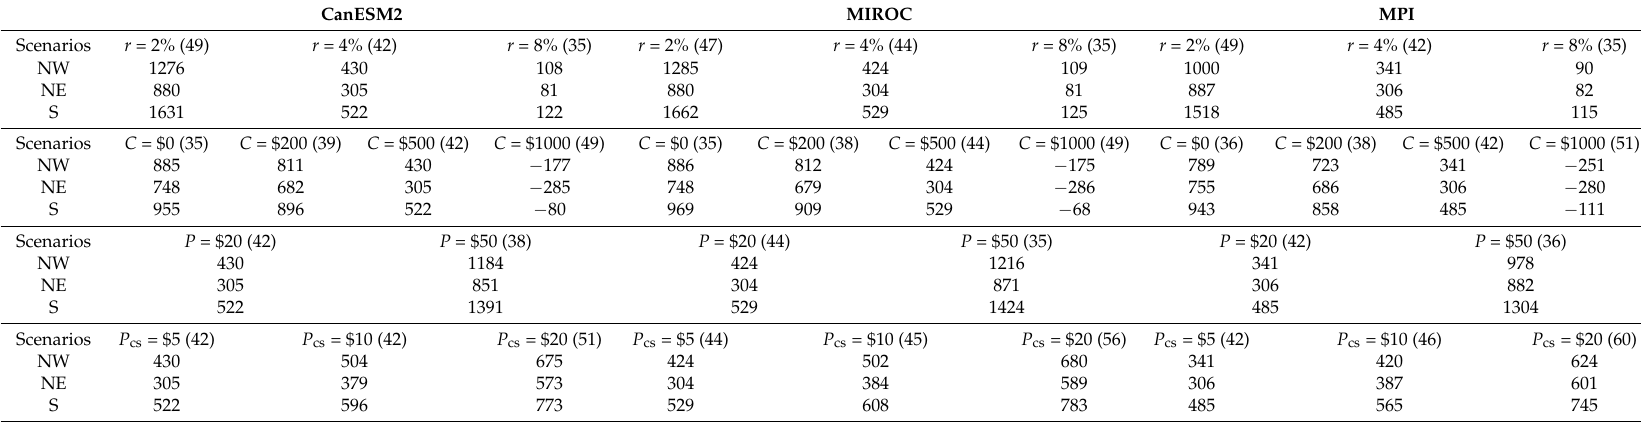
Table 4. Sensitivity analyses of wood plus carbon scenario, showing variation in NPV ($ · ha − 1 ) with varying discount rate ( r ), establishment cost ( C ), stumpage value ( P ), and carbon price ( P cs